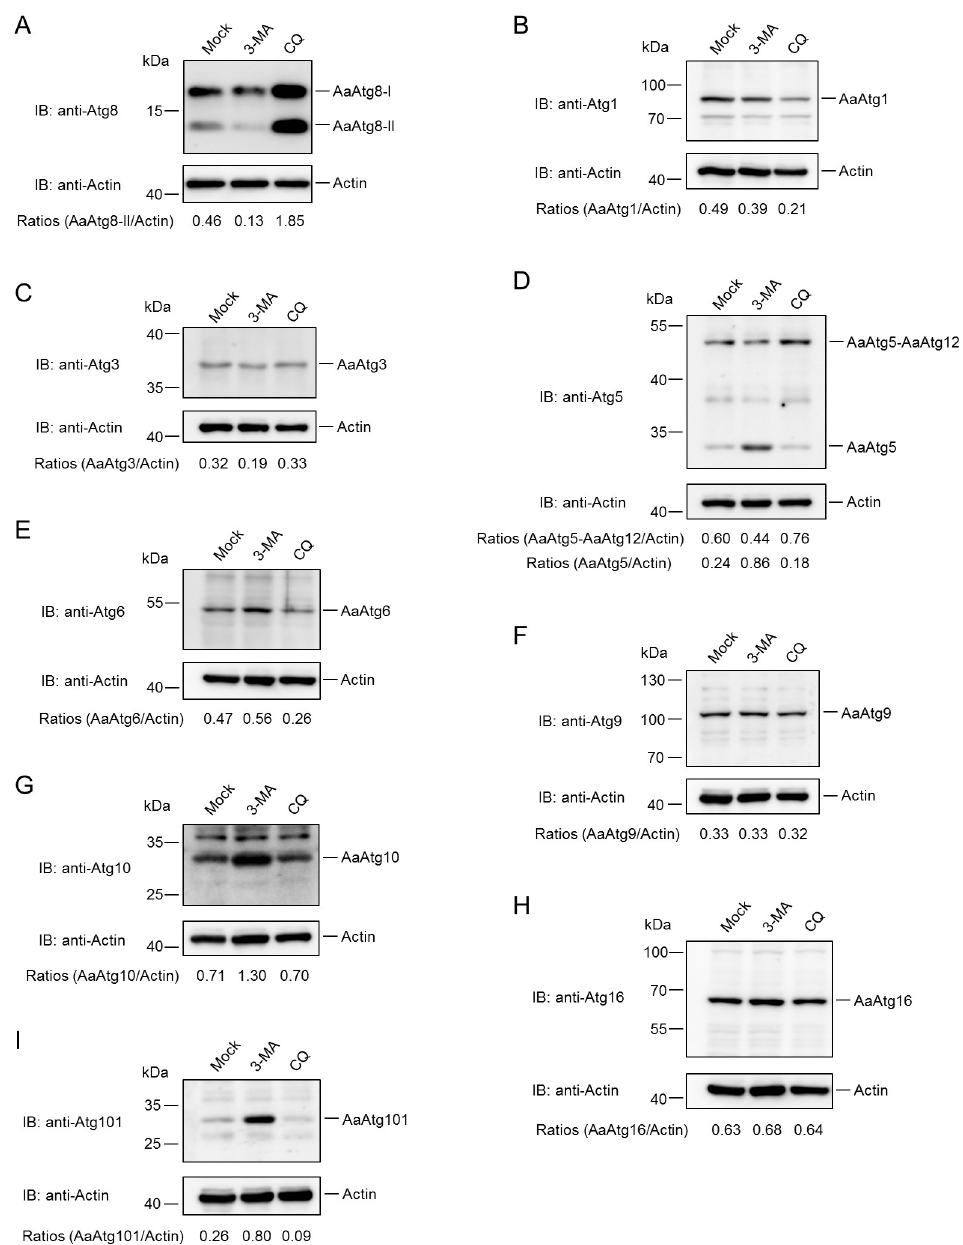
Fig 4. Responses of AaAtg proteins to 3-MA and CQ. (A)—(I) C6/36 cells were mocked treated or treated with 3-MA (5mM, dissolved in ddH 2 O) or CQ (300 μ M, dissolved in ddH 2 O) for 36 hours, respectively. The protein levels of AaAtg8, AaAtg1, AaAtg3, AaAtg5, AaAtg6, AaAtg9, AaAtg10, AaAtg16, AaAtg101 and actin were analysed by Western Blotting, respectively. The relative level of each AaAtg protein to that of actin was quantified by ImageJ according to materials and